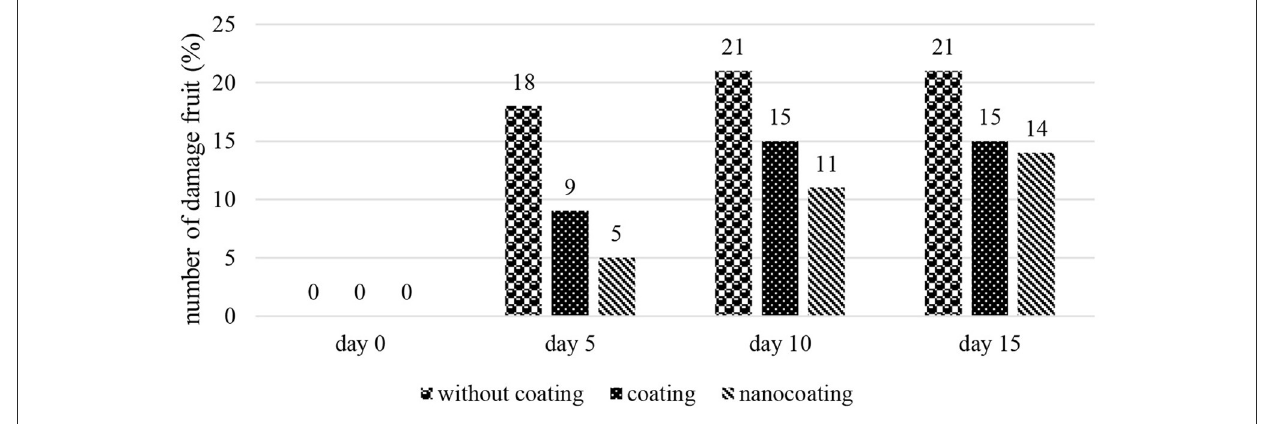
FIGURE1 Number of damages of Siamese orange fruit (%).